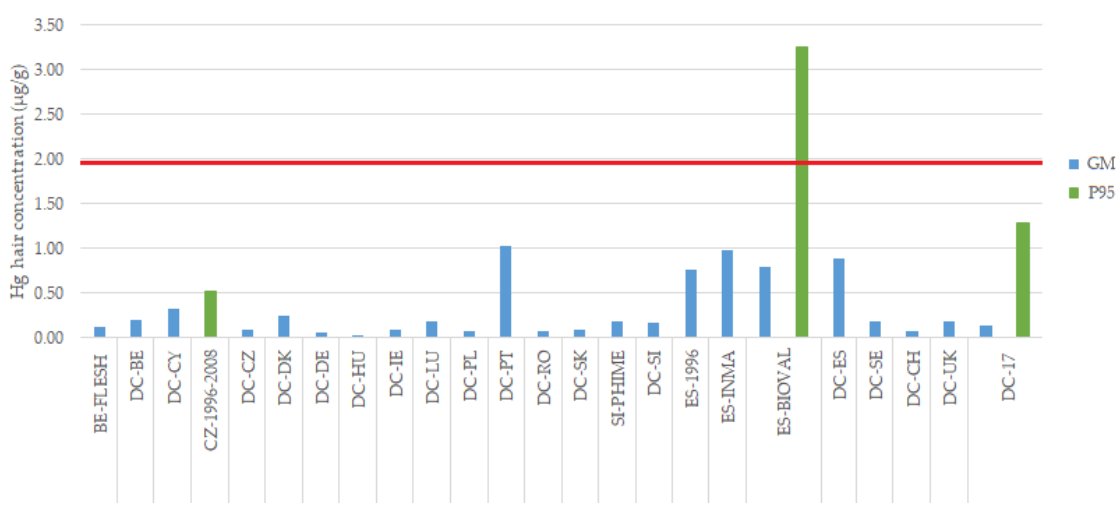
Figure 4. Exposure levels (Hg in hair, GM and P95) in children/adolescents (3–17 years old) from the EU general population compared to the internal exposure guideline value for Hg in hair derived from EFSA (1.9 µg/g, in red). DEMOCOPHES Study (DC). Note: MeHg levels in the case of FLESH study.